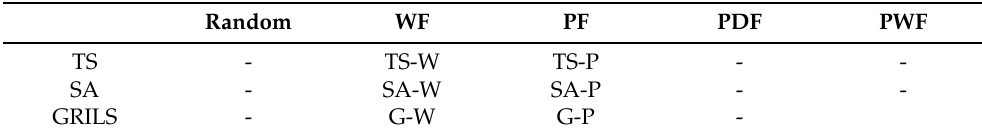
Table 3. Competitors.